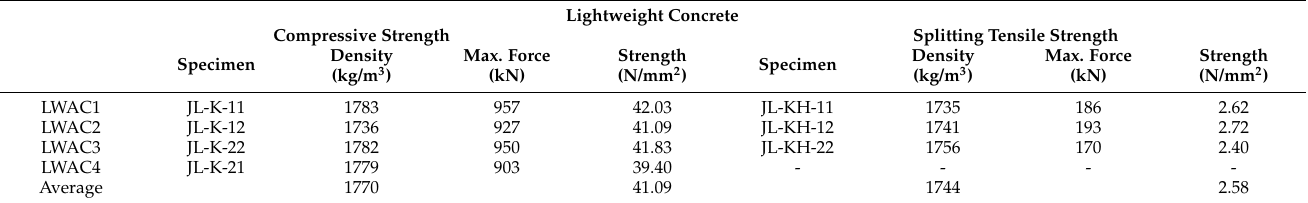
Table 3. Compressive and splitting tensile strength of lightweight